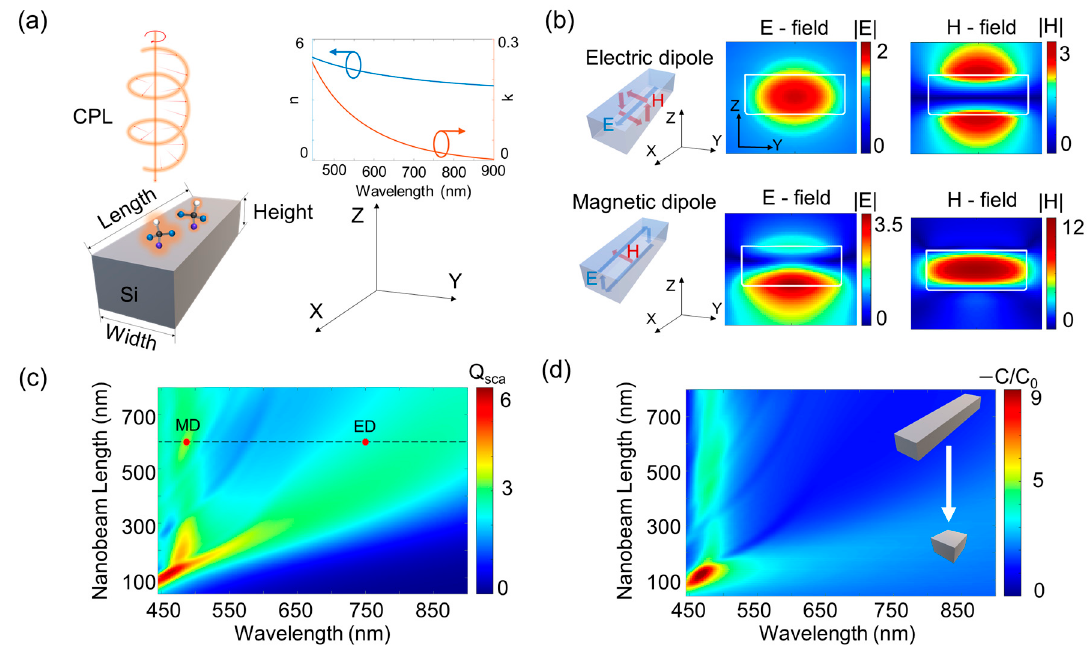
Figure 1. ( a ) Schematic of the resonant dielectric nanostructure as a unit cell. The nanostructure is designed with a constant cross-sectional area (60 nm by 125 nm) and various lengths. ( b ) The profiles of the scattered electric and magnetic fields for the nanorod with the length of 600 nm under the incident light that is linearly polarized parallel to the x-axis. It supports the resonances with the magnetic dipole (MD) and the electric dipole (ED) at the target wavelengths of 475 nm and 750 nm, respectively. ( c ) Numerically simulated scattering efficiency (Q sca ) of silicon (Si) nanostructures for the continuously tuned lengths of the nanostructure. Light is illuminated with the right-handed polarization. The condition of dipole resonances in ( b ) is indicated as red dots. ( d ) The calculated chiral enhancement (C enhancement, -C/C 0 ) of Si nanorods is in ( c ).